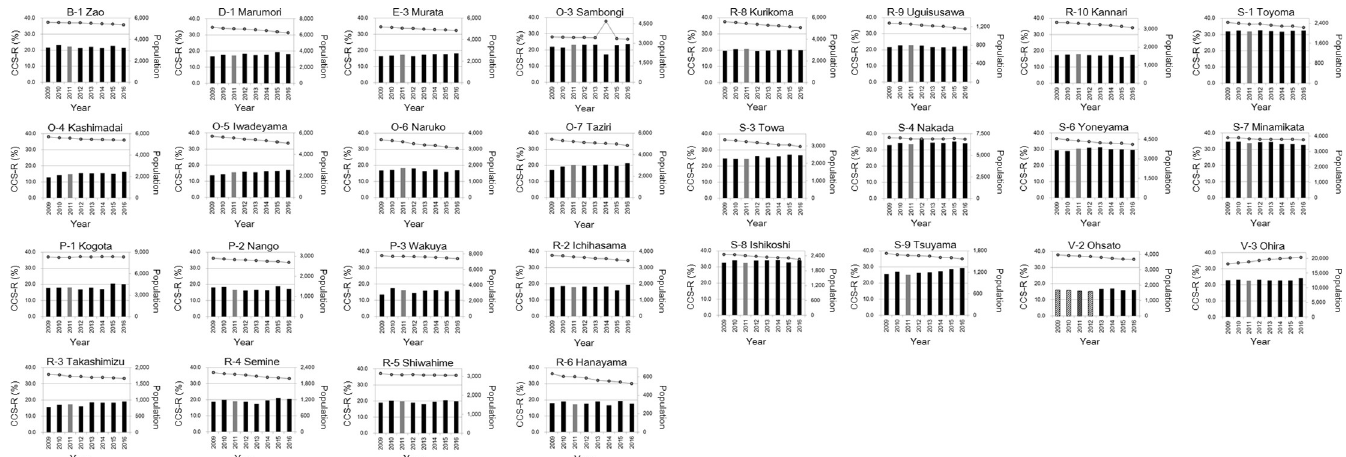
Fig 4. Change in the cervical cancer screening rate (CCS-R) in other non-coastal areas examined in this study. The bar graph shows the CCS-R (%), and the line graph shows the population (number of people).